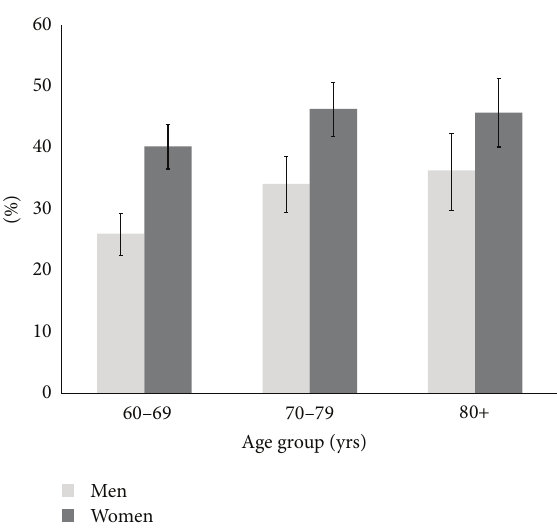
Figure 1: Prevalence of falls among older adults in Ecuador, SABE I.